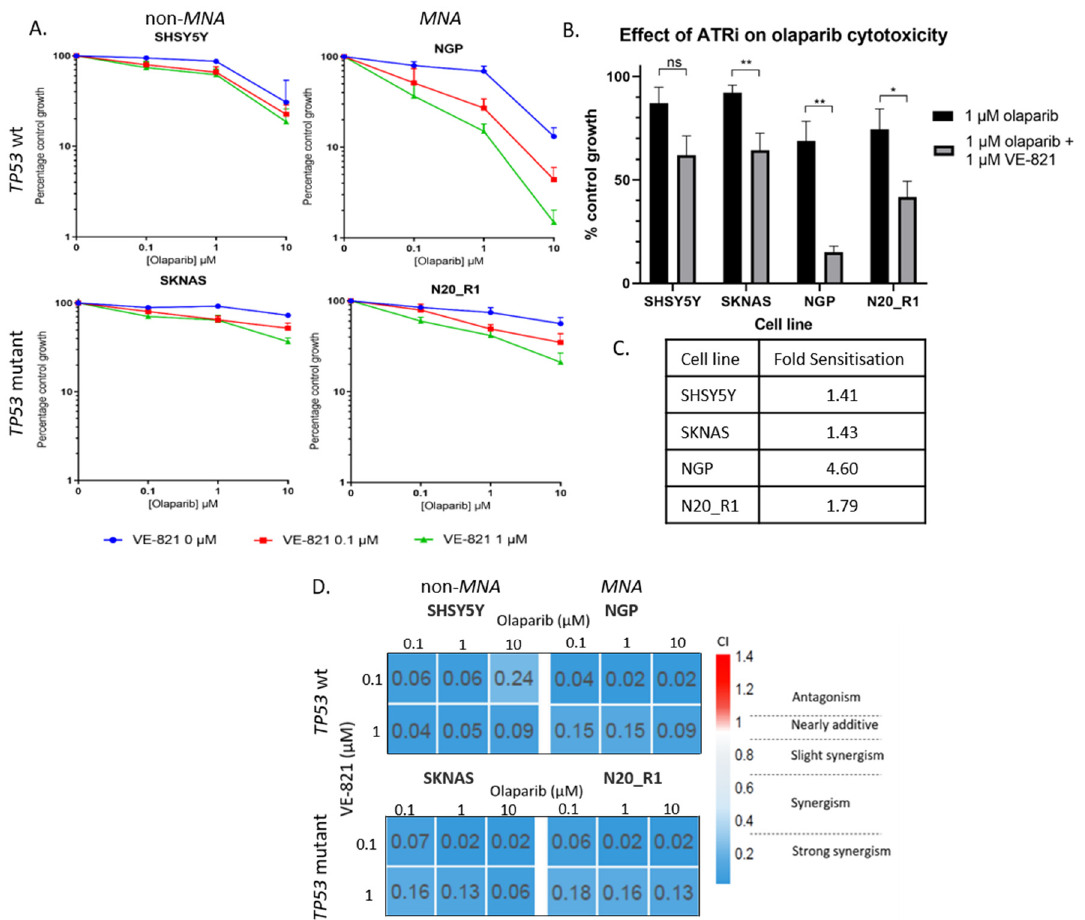
Figure 3. ( A ) XTT cell proliferation of the SHSY5Y, SKNAS, NGP and N20_R1 neuroblastoma cell lines treated with 0.1, 1 and 10 µ M olaparib alone and with the addition of 0 (blue), 0.1 (red) and 1 (green) µ M VE-821. Percentage control growth was normalised to e ff ect of VE-821 alone. Data shown are the mean + SEM from 4 individual experiments. ( B ) E ff ect of 1 µ M VE-821 on cytotoxicity of 1 µ M olaparib normalised to the e ff ect of VE-821 alone. Data shown are the mean + SEM from 4 individual experiments. T-test: ns; not significant, * p < 0.05, ** p < 0.01. ( C ) Fold sensitization of 1 µ M olaparib by 1 µ M VE-821 for each cell line. ( D ) Combination index (CI) values were calculated using CalcuSyn and plotted in heat map.